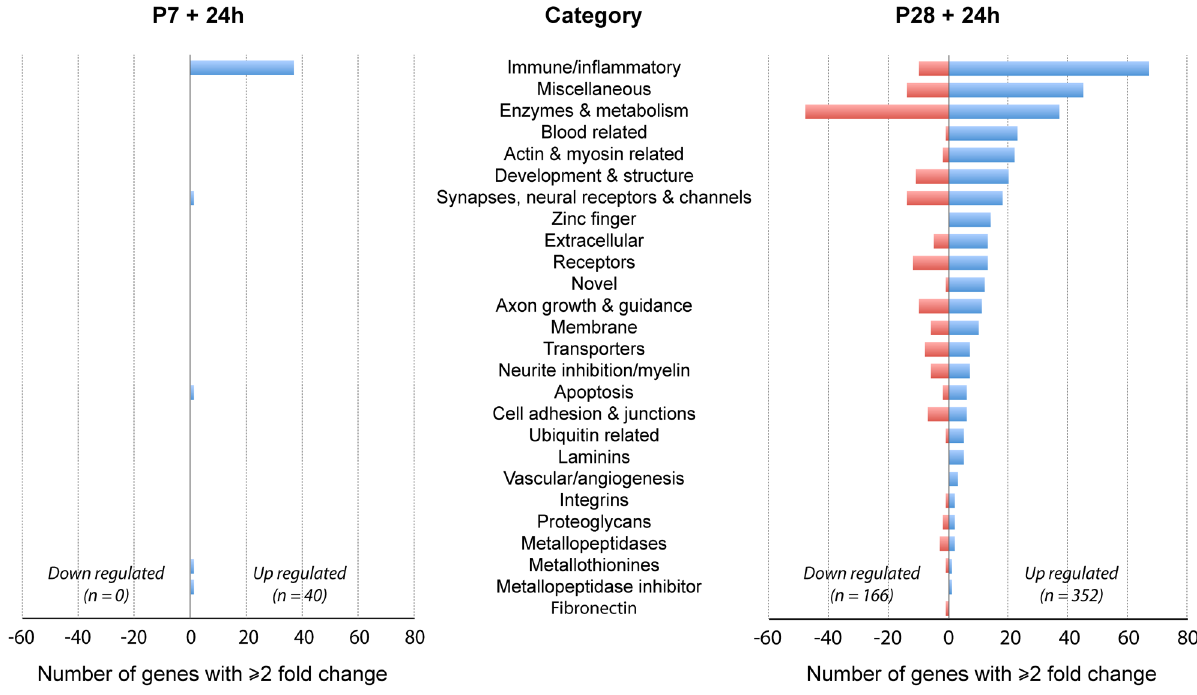
Figure 2. Changes in gene expression in spinal cord 24 h following transection at P7 or P28 in Monodelphisdomestica . Numbers of genes in each functional category that showed 6 $ 2 fold change compared to uninjured aged matched controls. Note dominance of immune/ inflammatory genes particularly at P7. Also note that at P28 many more genes showed expression changes (both up and down). See Tables S1 and S2 for gene descriptions, fold change and p